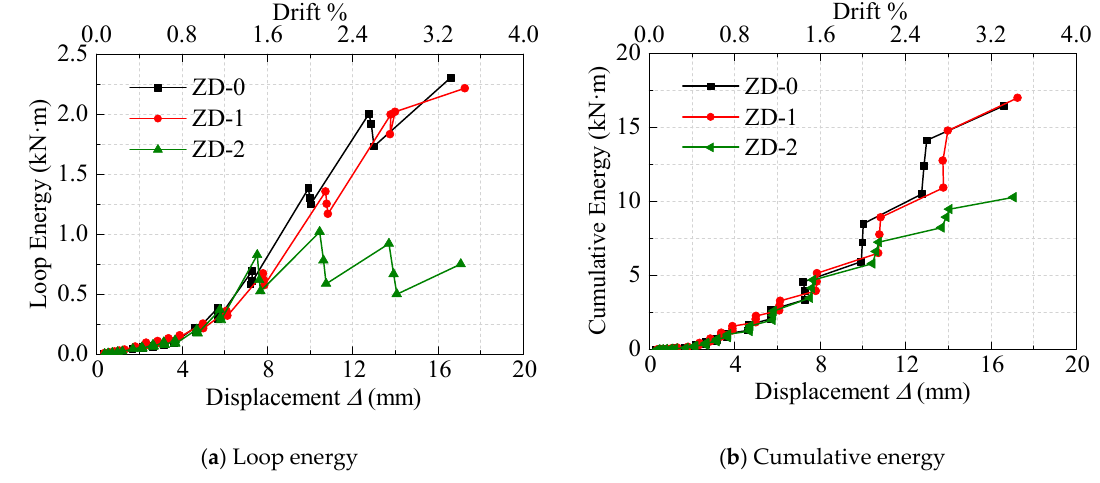
Figure 13. Energy dissipation versus lateral displacement.